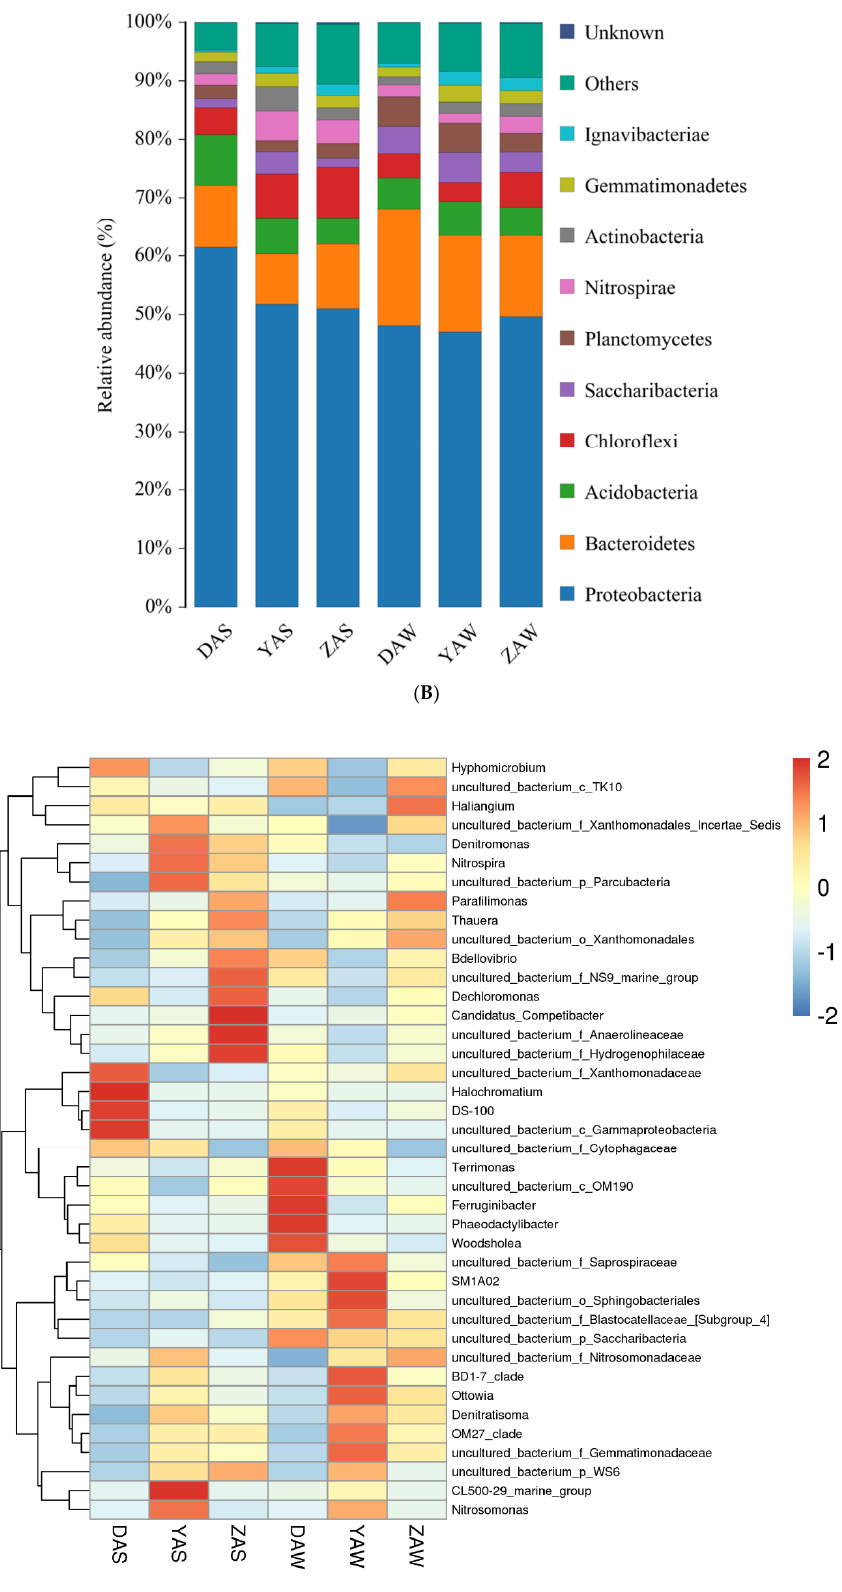
Figure 3. Relative abundance (( A ) phylum level) and heat map (( B ) genus level) of microbes in sludge samples collected from different wastewater treatment plants, at different times.